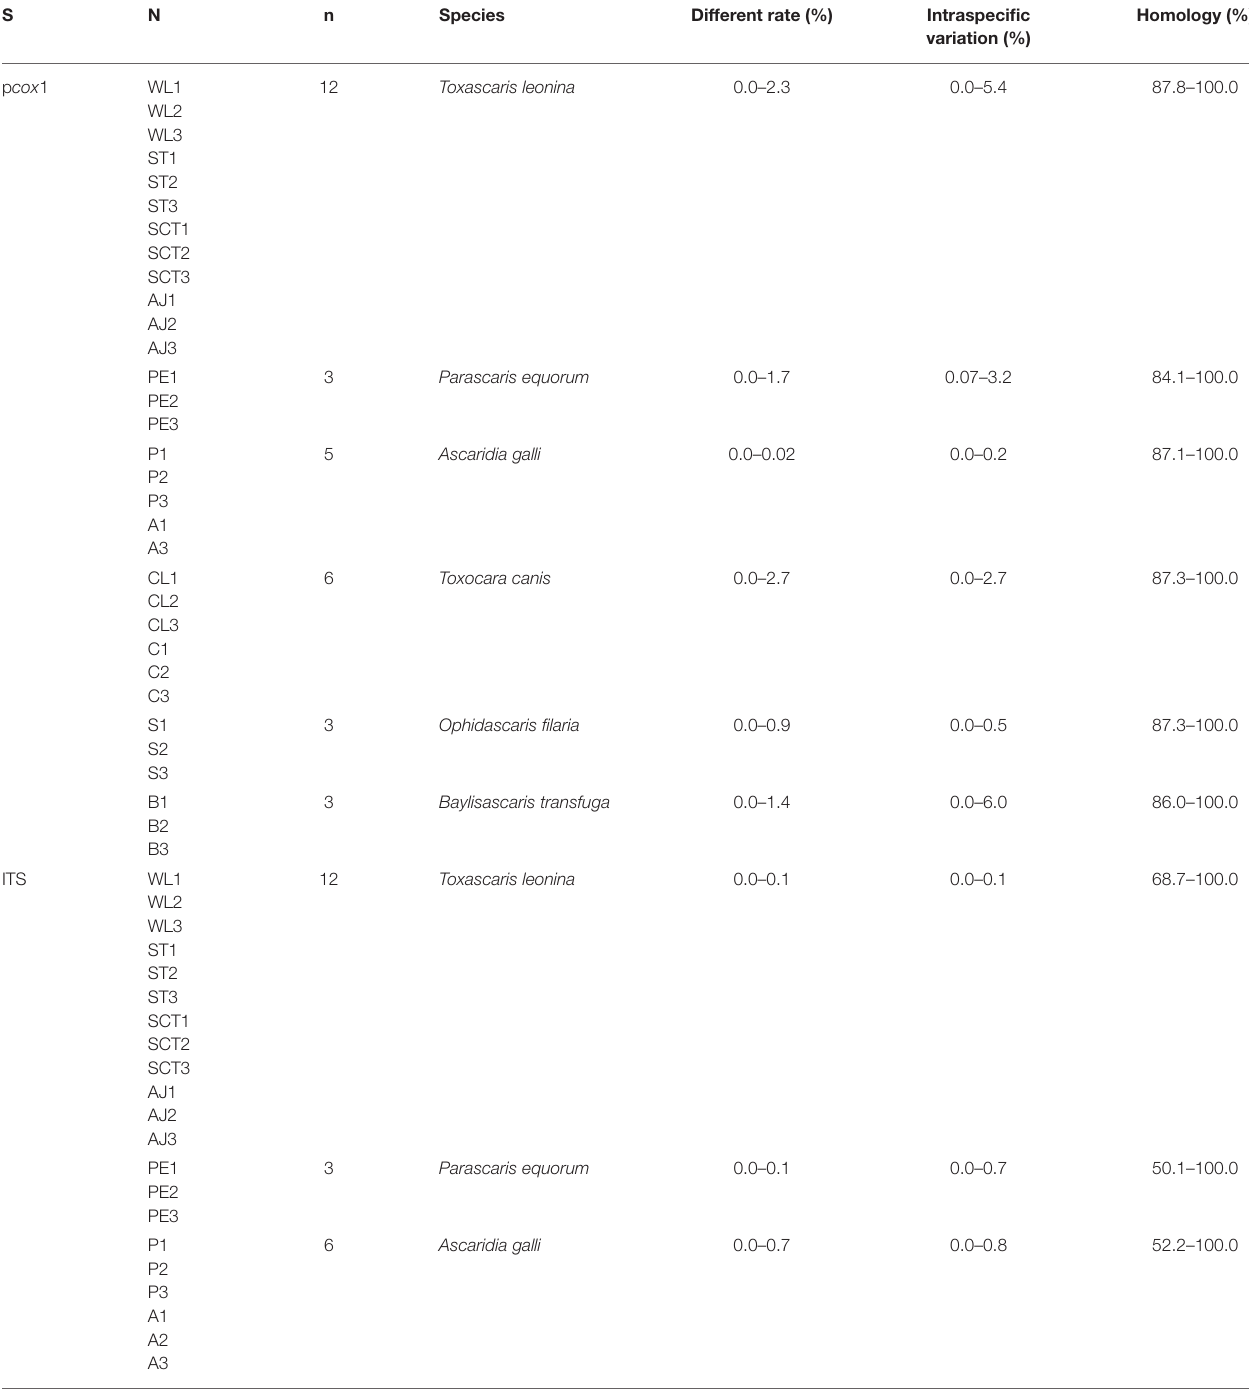
TABLE 2 | The nucleotide sequence homology analysis of p cox 1 and ITS genes. S n Species Different rate (%) Intraspecific